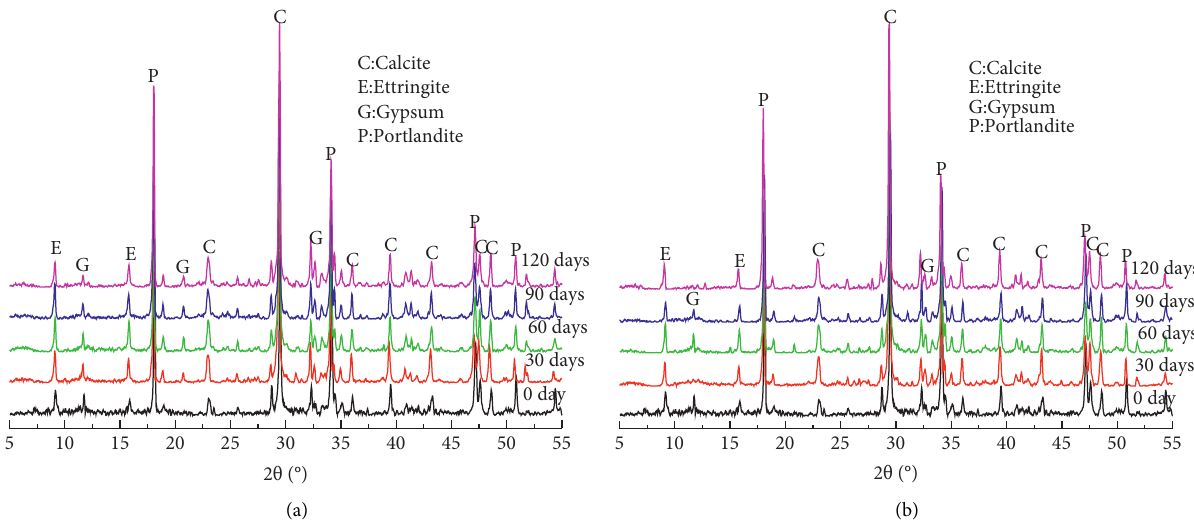
Figure 10: XRD pattern of 10% limestone powder content within 120 days. (a) Cathode surface and (b) anode surface.